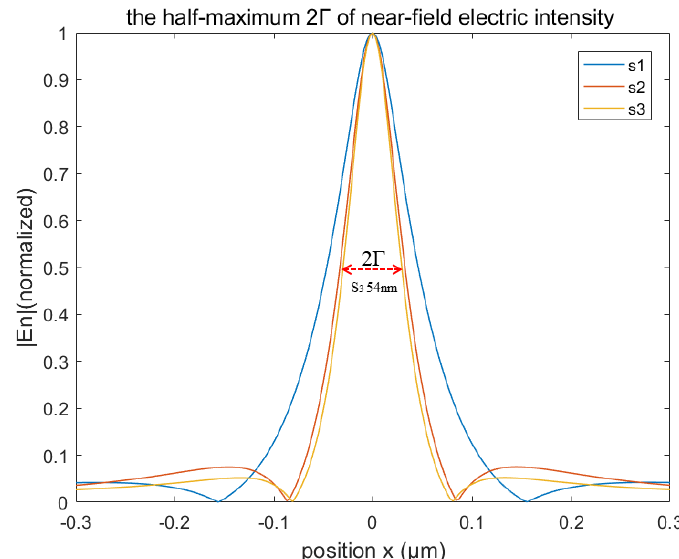
Figure 5. Line profiles with full width at half- maximum 2Γ extracted at 2 nm above the sample.